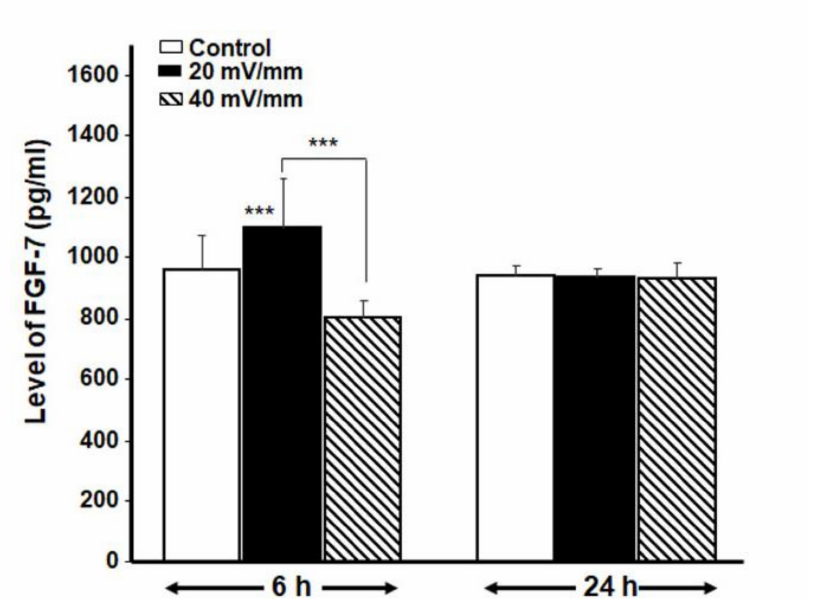
Figure 6. Effect of ES on FGF-7 secretion by the DHSF. ES at 20 mV/mm for 6 h significantly increased FGF-7. Values are means ± SD ( n = 4). *** p < 0.001. The control (no ES) and ES-exposed cells were compared, as well as the different ES